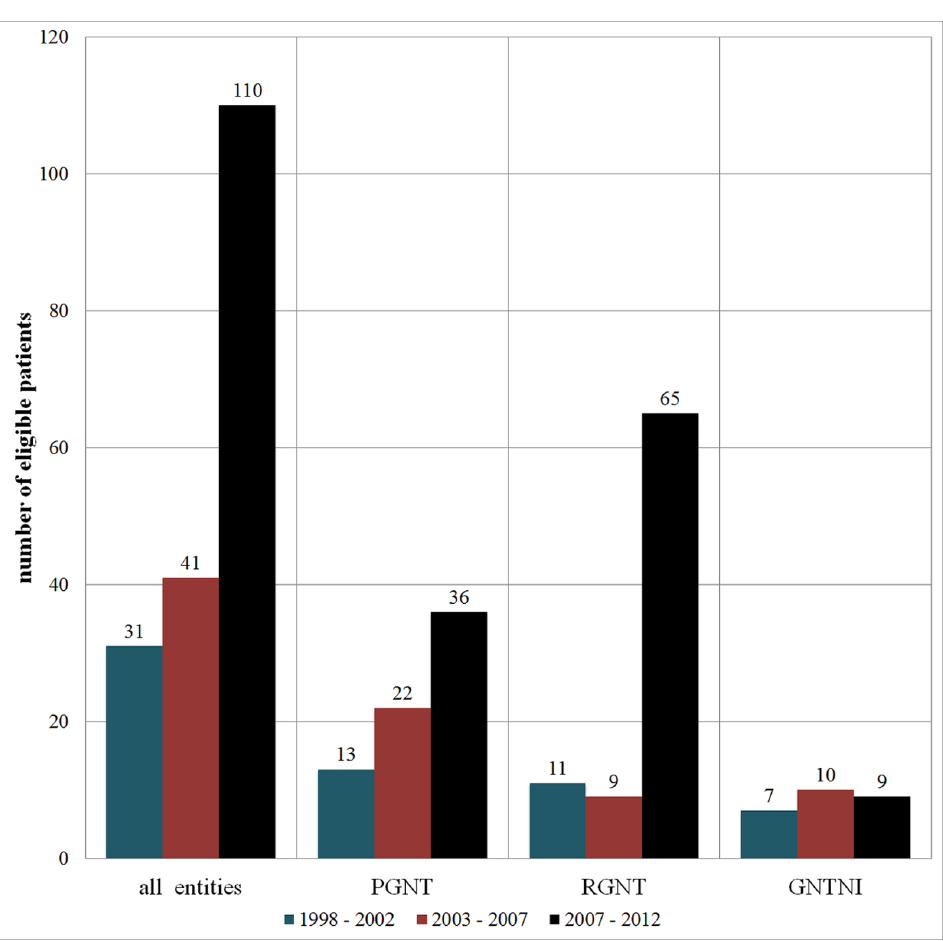
Figure 2. Number of published case reports. There is an increasing number of case reports over the last years. doi:10.1371/journal.pone.0101211.g002 PLOS ONE |